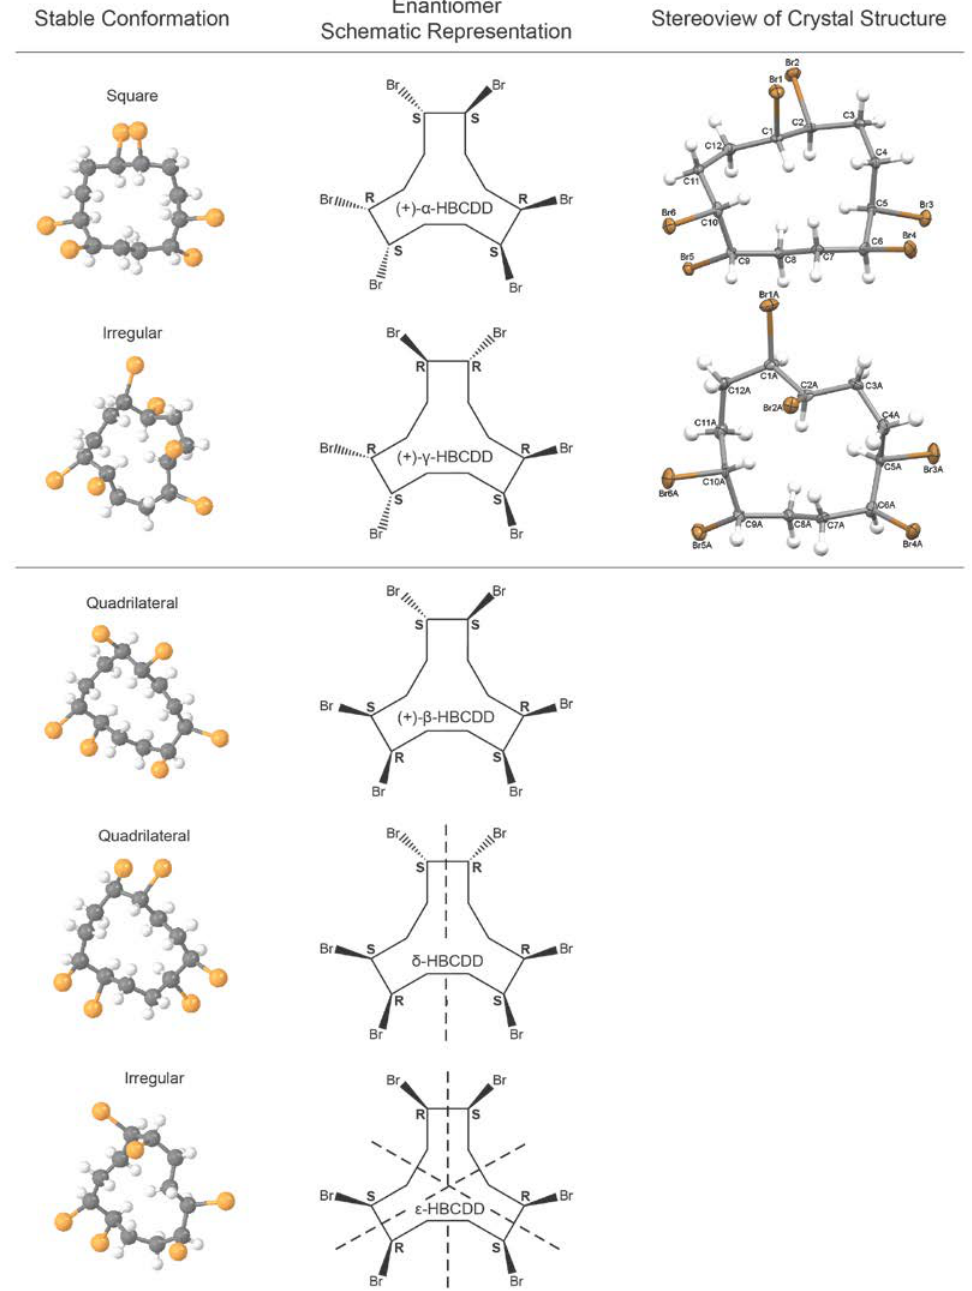
Figure 1. Stable conformations, schematic representations, and stereoviews of the crystal structures (when acquired) of enantiomerically pure (+)-α-HBCDD, (+)-γ-HBCDD, and (+)-β-HBCDD as well as the two minor isomers δ-HBCDD and ε-HBCDD.